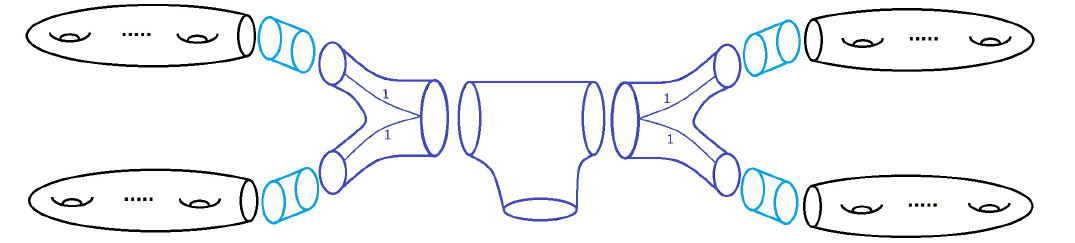
Figure 3 . The interpretation of the inner product (6.40) in terms of